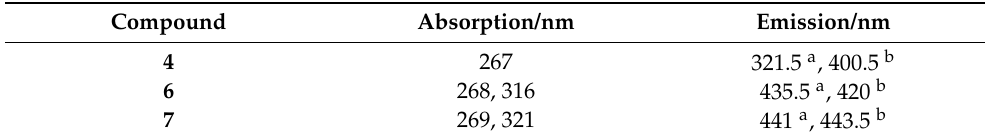
Figure 3. Normalized UV/vis absorption spectra of 4 , 6 and 7 in CH 3 CN. Table 1. Collection of spectroscopic